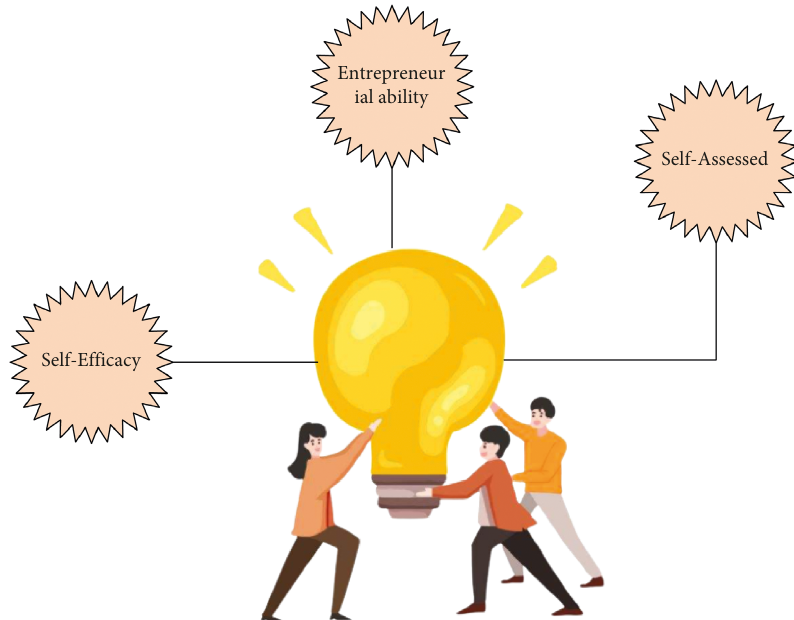
Figure 4: Principal component analysis is applied to the evaluation of